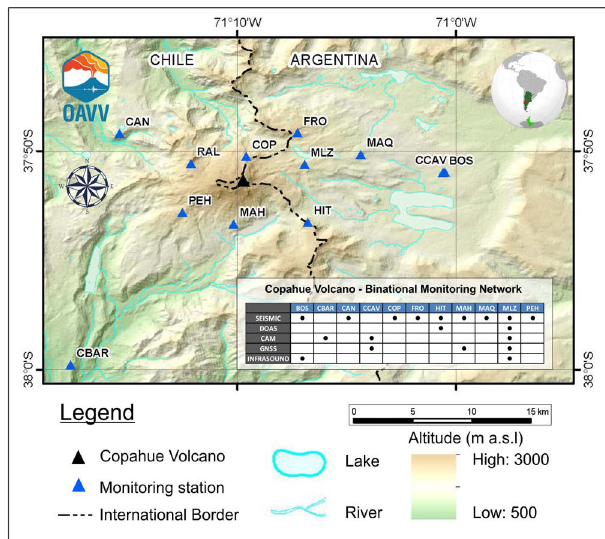
Figure 3: Binational volcano monitoring network for Co- pahue